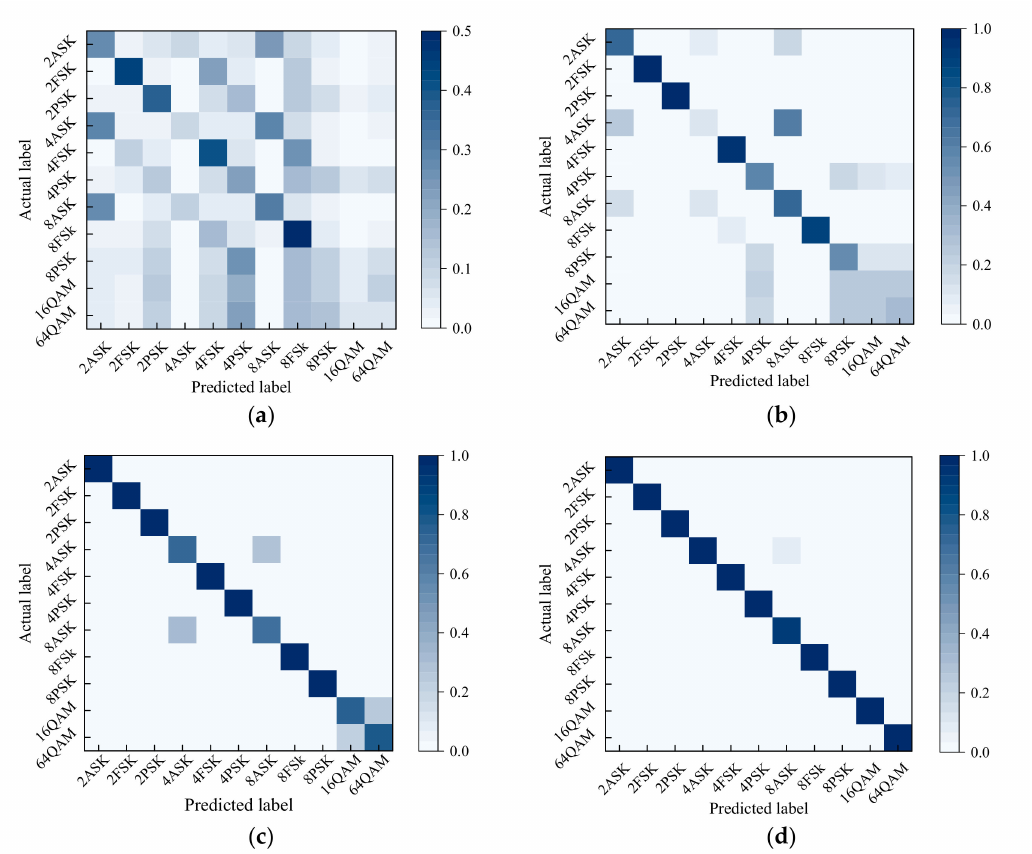
Figure 9. Confusion matrix with di ff erent SNRs: ( a ) SNR = − 20 dB; ( b ) SNR = − 10 dB; ( c ) SNR = 0 dB and ( d ) SNR = 10 dB.